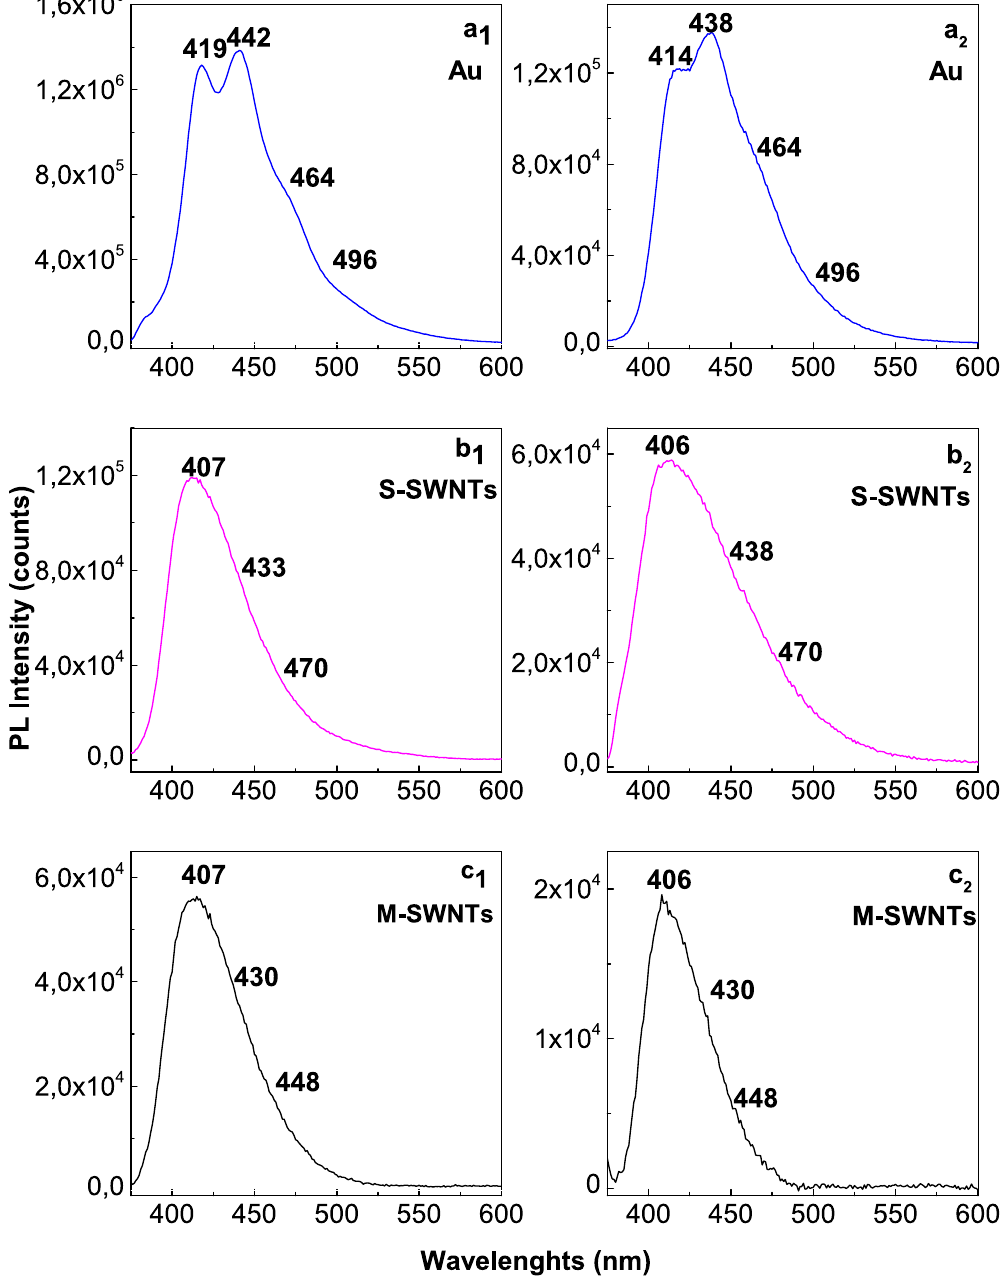
Figure 6. The PL spectra of the samples of PANI doped with HSO 4 − and Cl − ions, respectively, electrosynthesized during the 30 CVs onto the blank Au electrode ( a 1 and a 2 ) and the Au plates covered with films of S-SWNTs ( b 1 and b 2 ) and M-SWNTs ( c 1 and c 2 ), after the interaction with the 1 M NH 4 OH